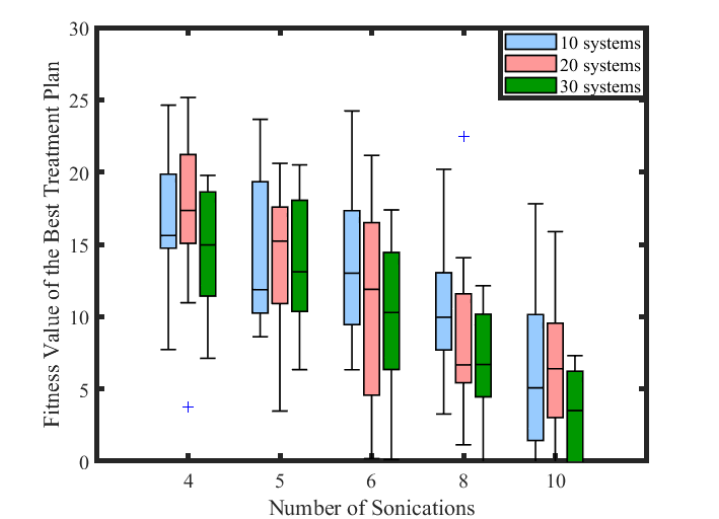
Figure 11. Histogram of the best fitness values from 15 independent runs as a function of the number of systems and the number of